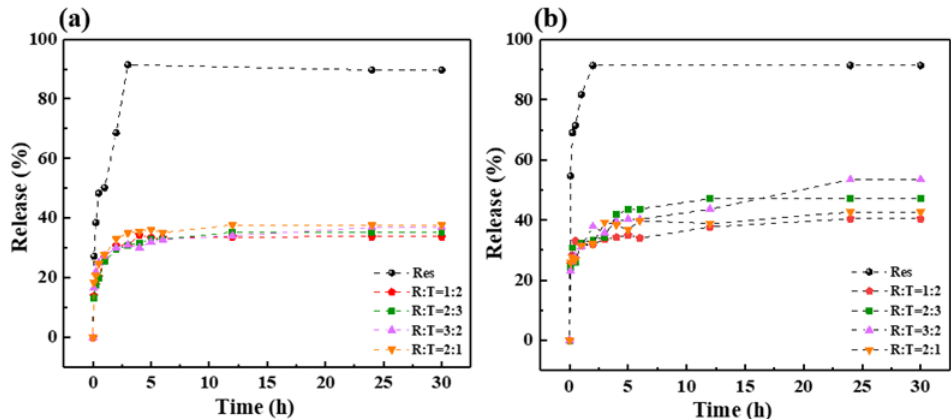
Figure 8. Res and RLTAs in ( a ) simulated gastric juice and ( b ) phosphate buffer.